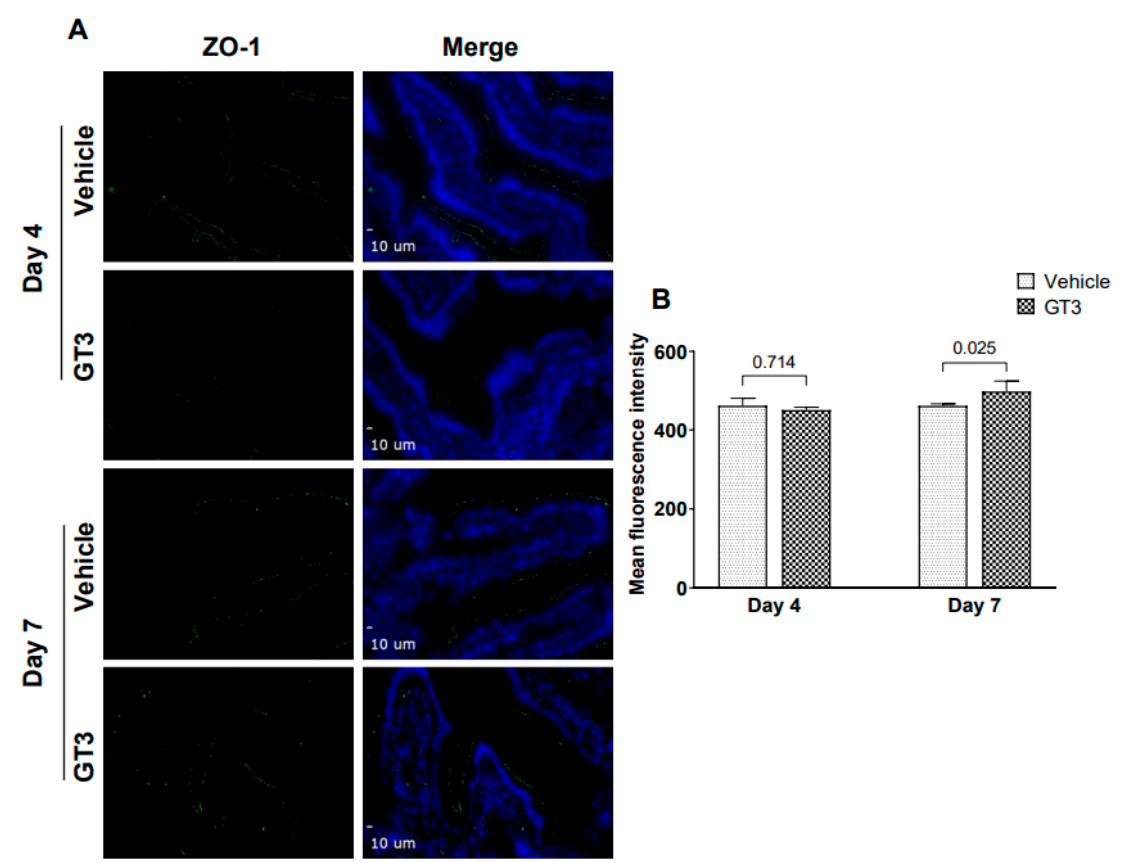
Figure 7. Effects of GT3 on ZO-1 expression in intestine. ( A ) Representative photomicrograph of ZO-1 expression (green) in the cross sections of the intestine at day 4 and day 7 post-irradiation. ( B ) Quantitation of ZO-1 expression levels in intestine at indicated time points post-12 Gy TBI. The data are presented as average ± SEM; N = 3 (day 4) and N = 5 (day 7).